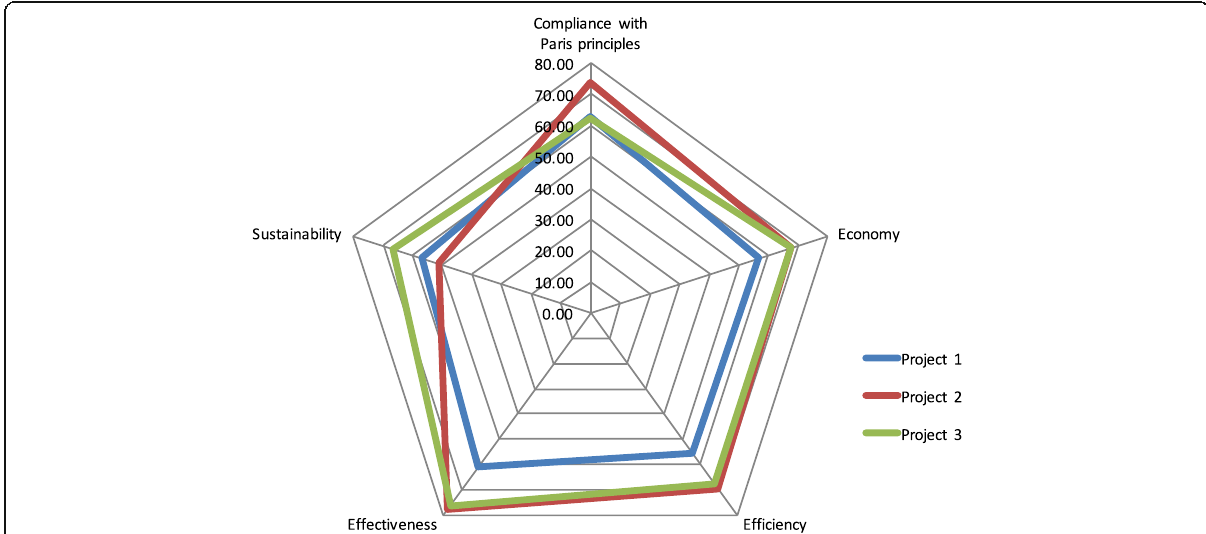
Fig. 2 Scores derived from stakeholder opinions on different aspects of three aid-funded